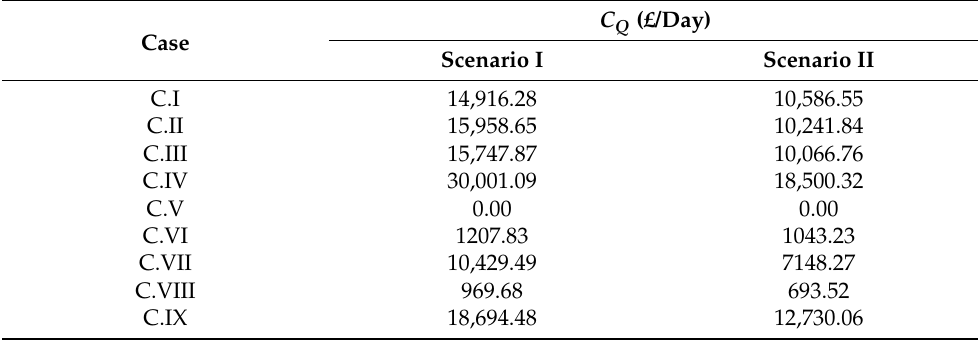
Table 2. Daily cost of reactive power supplied by the solar PVs implementing the nine reactive power control mechanisms.